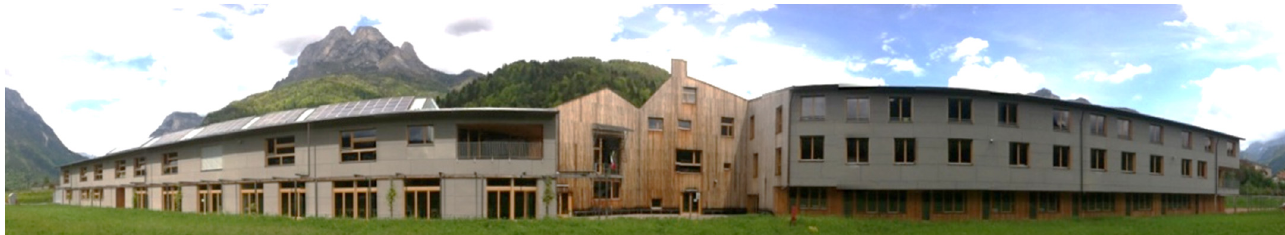
Figure 1. View of the school building in Agordo (from south).